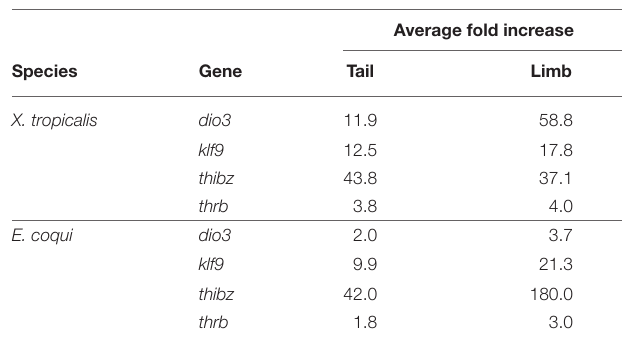
TABLE 3 | Induction of deiodinase type III ( dio3 ), krüppel-like factor 9 ( klf9 ), thyroid hormone induced bZip protein ( thibz ), and thyroid hormone receptor β ( thrb ) in